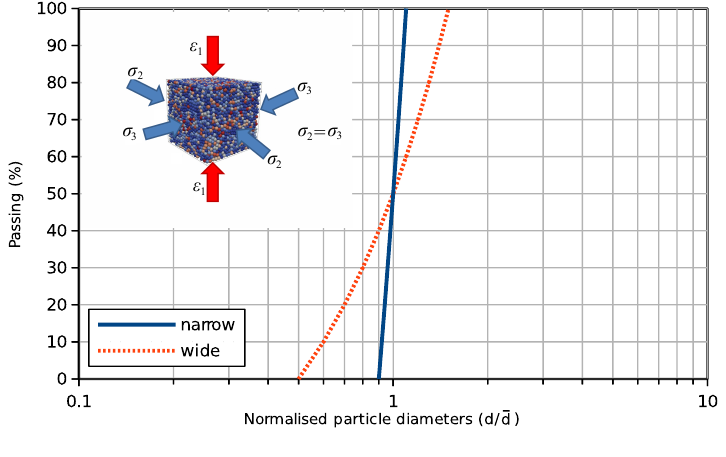
Figure 3. Particle size distributions. Summary of the parameters used for the DEM simulations. RVE, representative volume